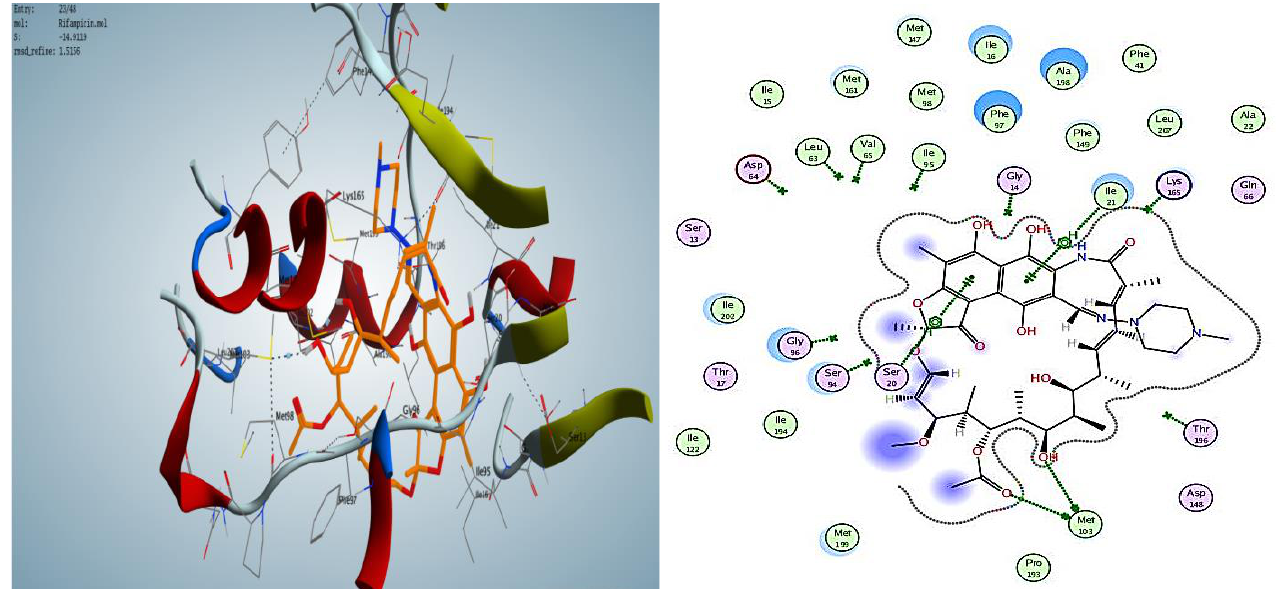
Figure 13. Docking and binding pattern of Isoniazide into inhA active site (PDB ID: 4TRO) in 2D (right panel) and 3D (left panel).